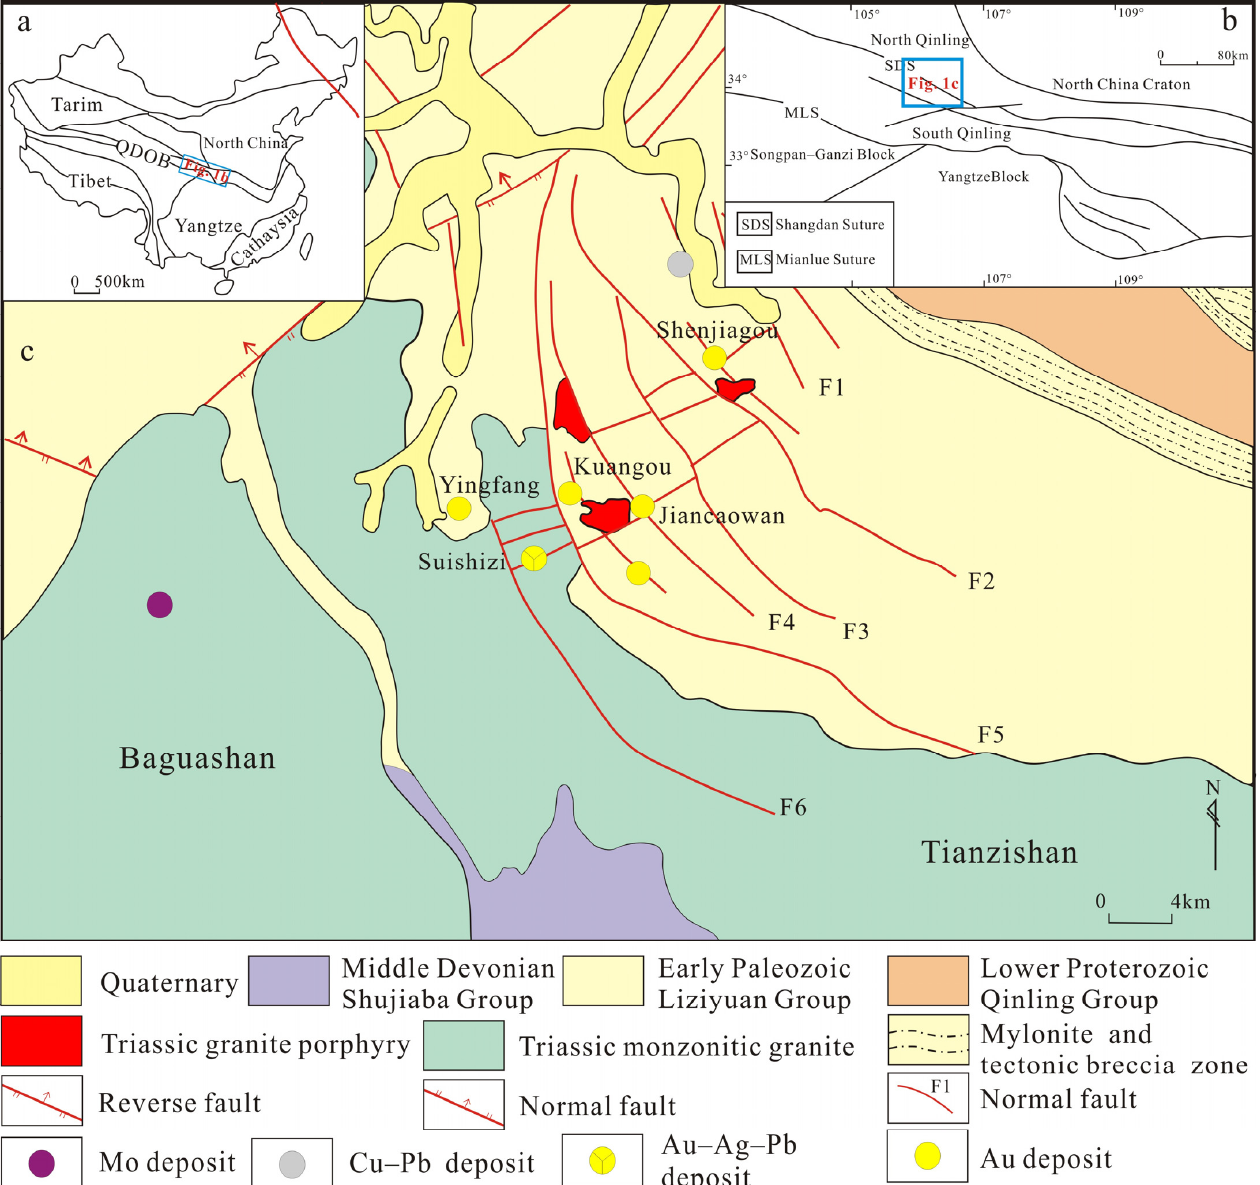
Figure 1. ( a ) Sketch map of China showing the location of the Qinling orogenic belt (QDOB, Qinling–Dabie Orogenic Belt). ( b ) Simplified tectonic map of the Qinling orogenic belt showing the location of the study area. ( c ) Simplified geological map of the Liziyuan area.